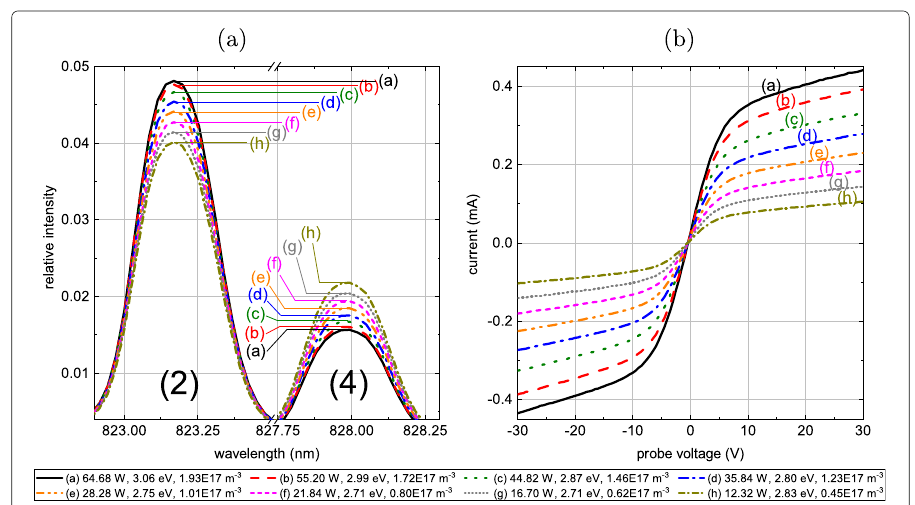
Fig. 5 The two strongest lines (see Fig. 4) of intensity-normalized xenon spectra for a measurement series at 0.1sccm gas flow at different operating points (see also Fig. 6) ( a ) together with the corresponding Langmuir double probe measurements ( b ). This series of spectra is part of the reference data set